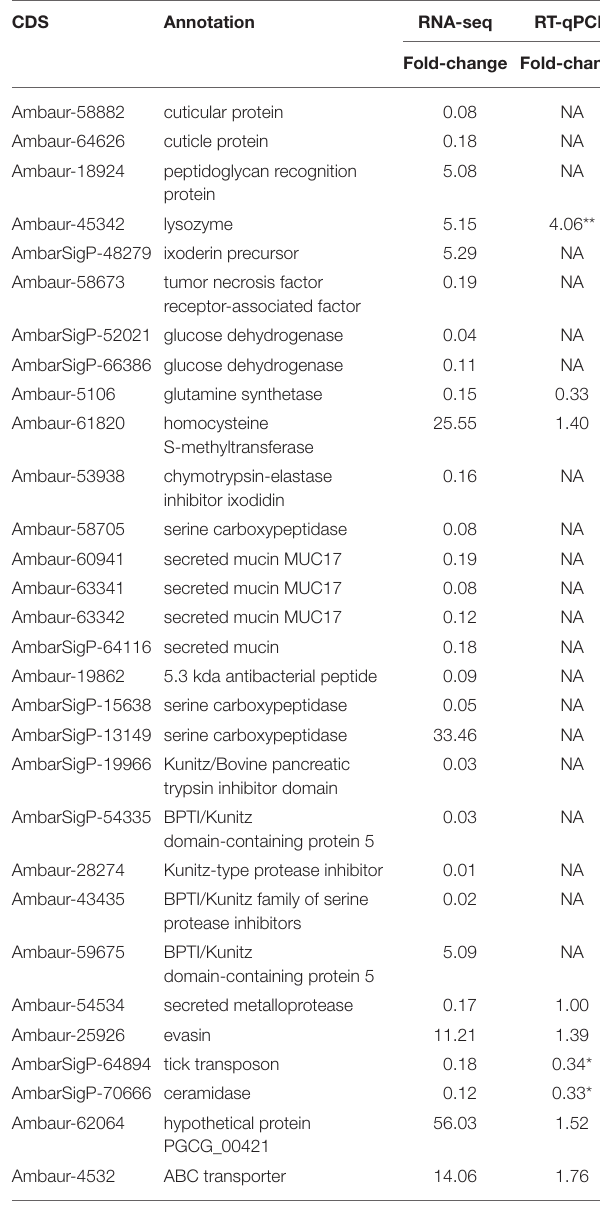
TABLE 3 | Selected CDSs of A. aureolatum midgut differentially expressed by infection with R. rickettsii .